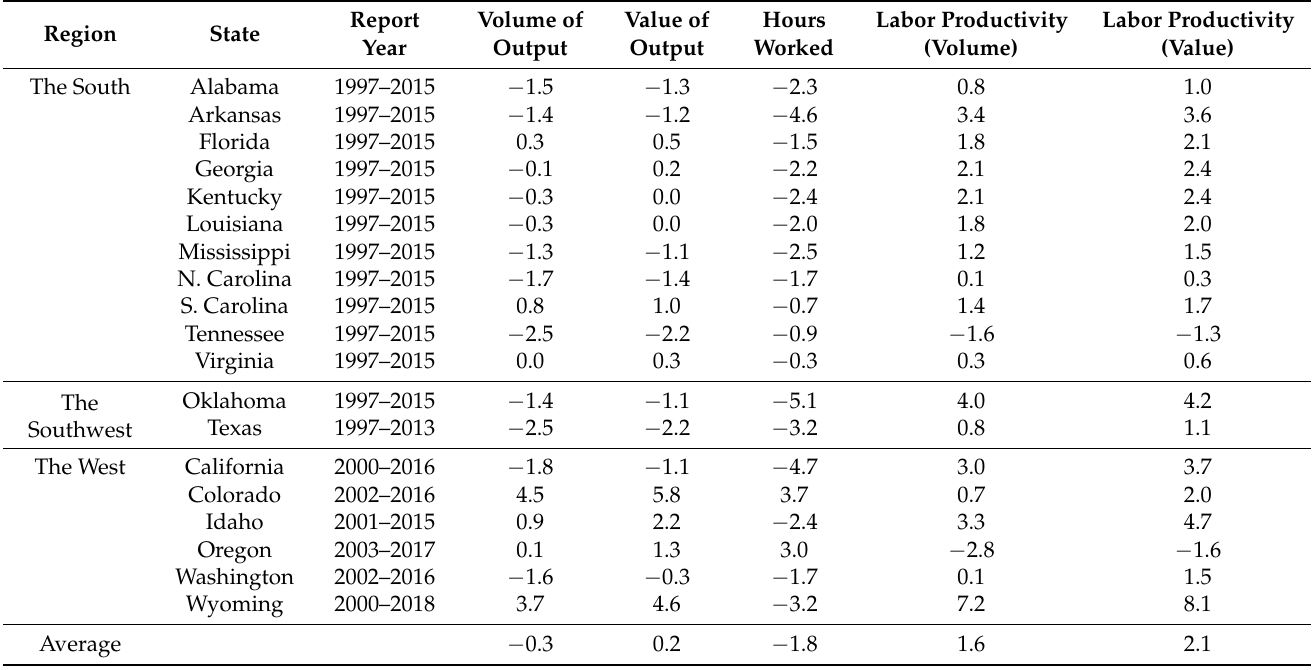
Figure 2. Age distribution of employees in the logging industry, U.S., 1997, 2007, and 2017 [38]. Technical advancement is another main reason for declining employment. We esti- mated the rate of growth in labor productivity of some states in the South, Southwest, and the West (Table 2). The Volume of Output column and the Value of Output column are the rate of growth in the volume of logging production and the economic value of logging production, respectively. The Hours Worked column is the rate of growth in hours worked. Except for Tennessee and Oregon, both rates of growth in labor productivity were positive. The output and hours worked declined in most states since 1997, but output declined at a slower pace than hours worked, which led to labor productivity growth. These findings are consistent with the studies in Uruguay, Argentina, Brazil [22], New Zealand [4], and Nordic countries [21]. Table 2. The rate of growth in output, hours worked, and labor productivity, U.S. (%) [37,43]. Region